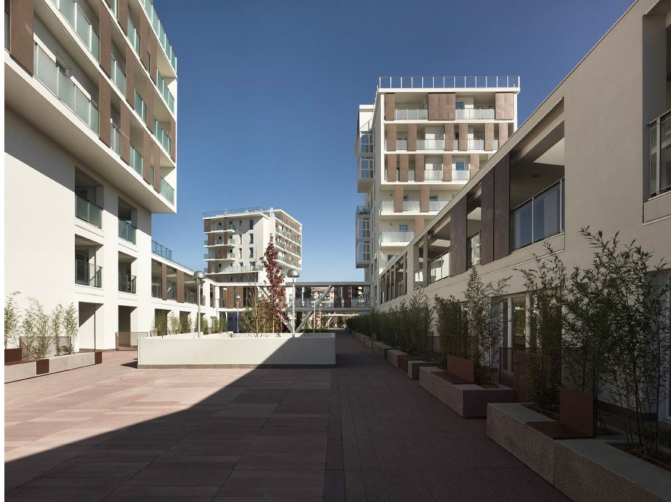
Figure 4. Via Cenni social housing complex in Milan, Photograph by Pietro Savorelli